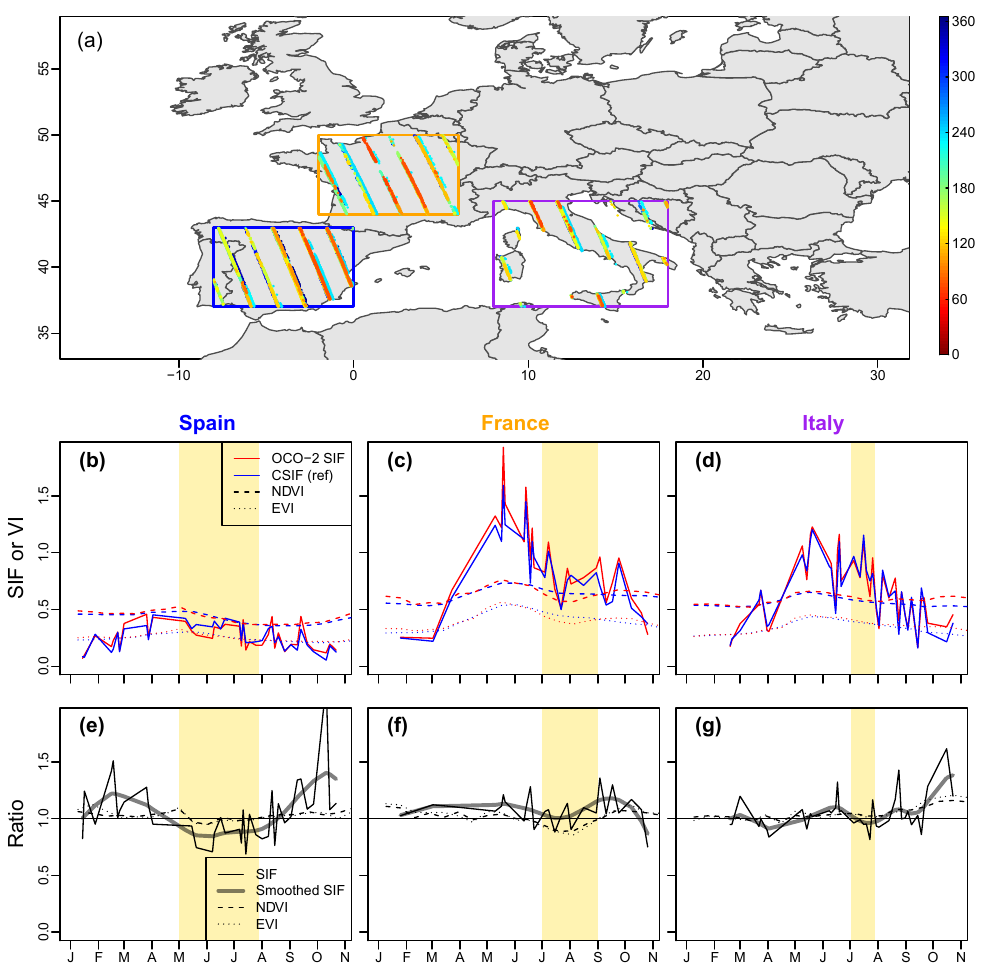
Figure 12. (a) Spatial distribution of OCO-2 SIF observations during 1 January to 1 November in 2015. Different colors represent the observation DOY. (b–d) Average OCO-2 SIF, CSIF NDVI and EVI for the three countries as indicated by three boxes in panel (a) . For two vegetation indices, the red color represents the observations in 2015 and blue color represents multi-year average (2000–2014). (e–g) The ratio between OCO-2 SIF and CSIF (SIF) or vegetation indices in 2015 and multi-year average. The thick grey line presents the splines’ smoothed SIF